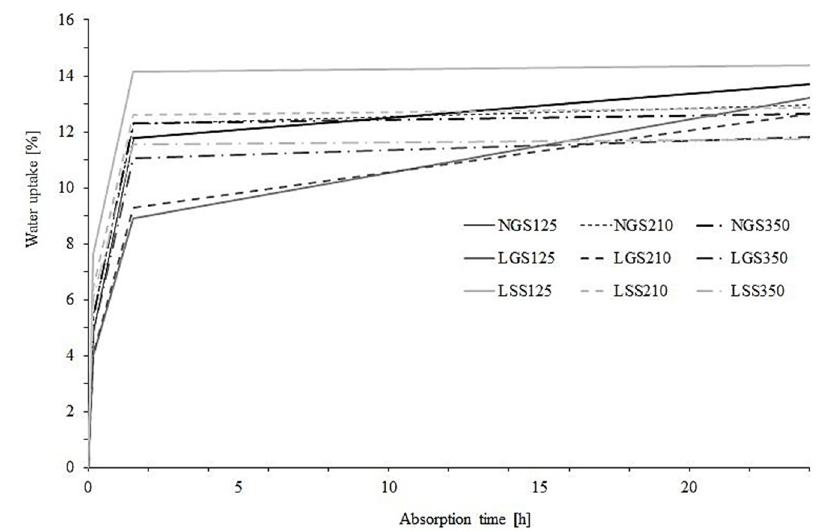
Figure 12. Water absorption curves.